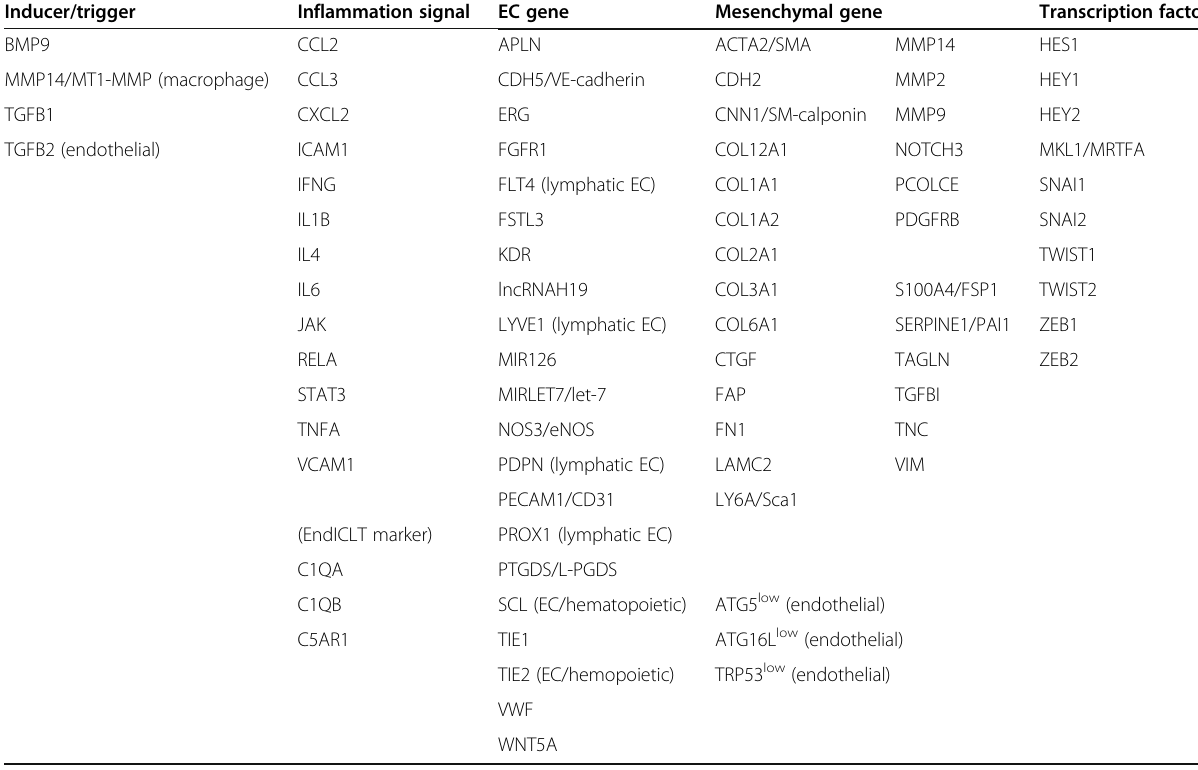
Table 1 List of EndoMT-related markers and inflammation-related genes in articles introduced in this review